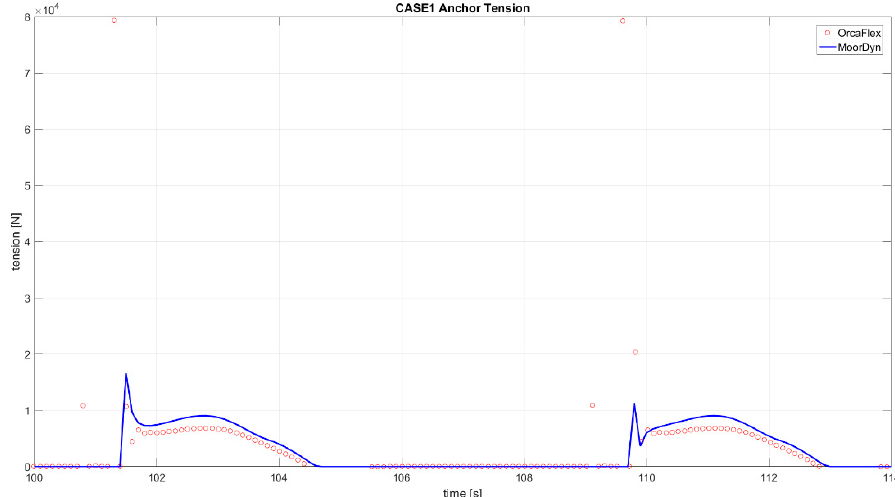
Figure 7. Simulation case 1: Time series of anchor tension at t = 100 s until t = 114 s. OrcaFlex results are represented as points instead of continuous line in order to highlight the overshoot values.